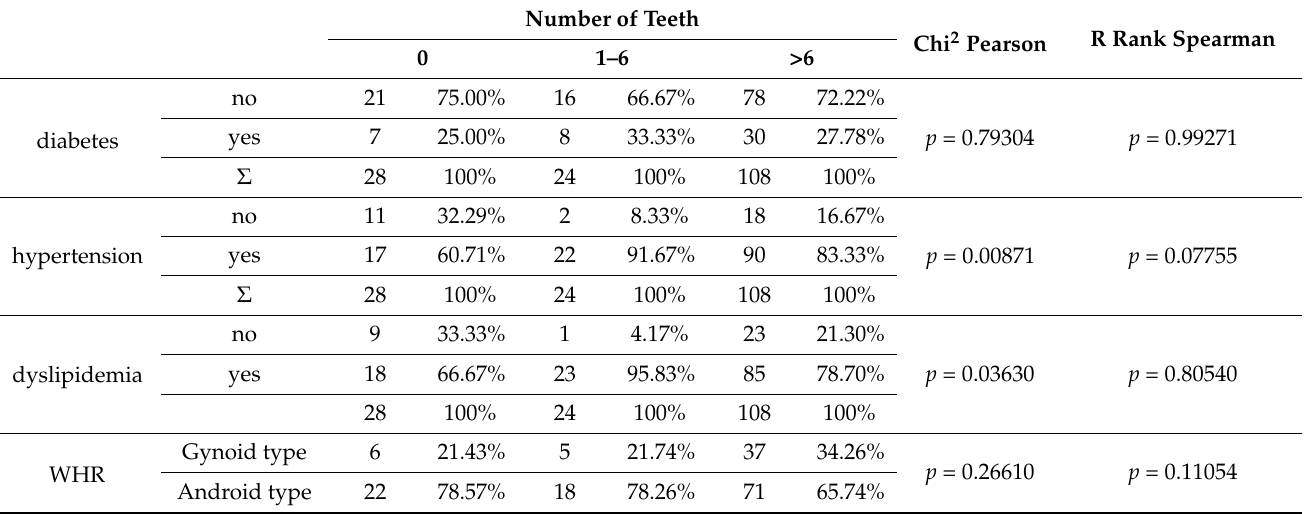
Table 8. The number of teeth and prevalence of diabetes, hypertension, dyslipidemia, and abdominal obesity in patients after acute myocardial infarction.